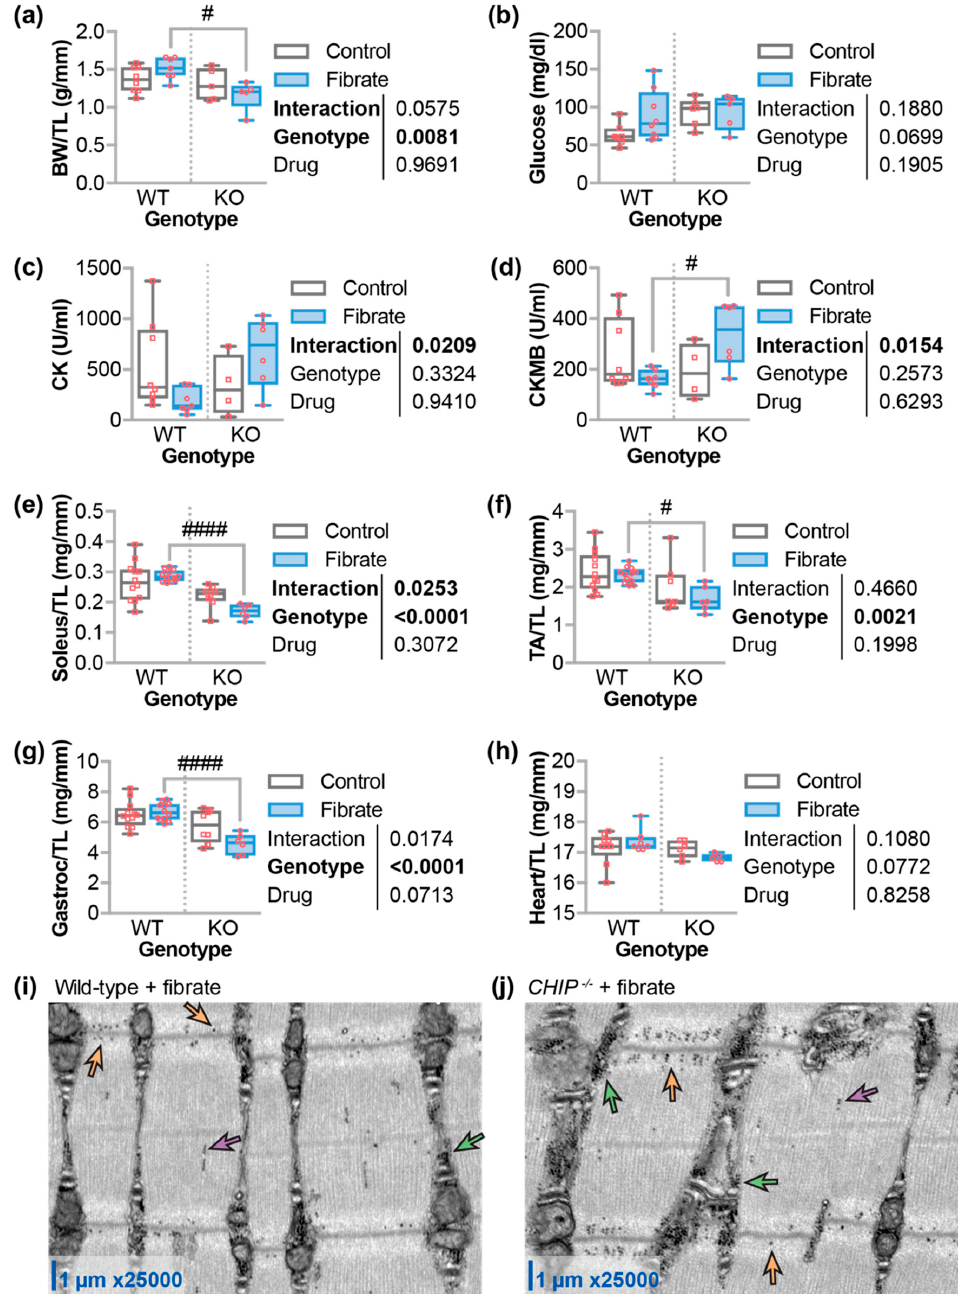
Figure 4. Fenofibrate effects on body weight, glucose levels, and muscle. ( a ) Body weight (BW) normalized by tibia length (TL), circulating levels of ( b ) glucose, ( c ) creatine kinase (CK), or ( d ) creatine kinase MB (CKMB), and weights of ( e ) soleus, ( f ) tibialis anterior, ( g ) gastrocnemius (gastroc), and ( h ) heart, which was normalized by TL, in either wild-type (WT) or CHIP − / − (KO) mice that were fed control or fenofibrate chow represented by boxplot with biological replicates plotted. Results of two-way ANOVA are provided. Tukey’s post-test: # and #### indicate p < 0.05 and 0.0001 comparing WT vs. KO conditions. Transmission electron micrographs of gastrocnemius muscle sarcomeres from ( i ) wild-type and ( j ) CHIP − / − mice after five weeks of fenofibrate. Glycogen can be seen as small, dense, round objects highlighted by arrows and found in the I-band (orange), A-band (purple), and sarcoplasm (green).